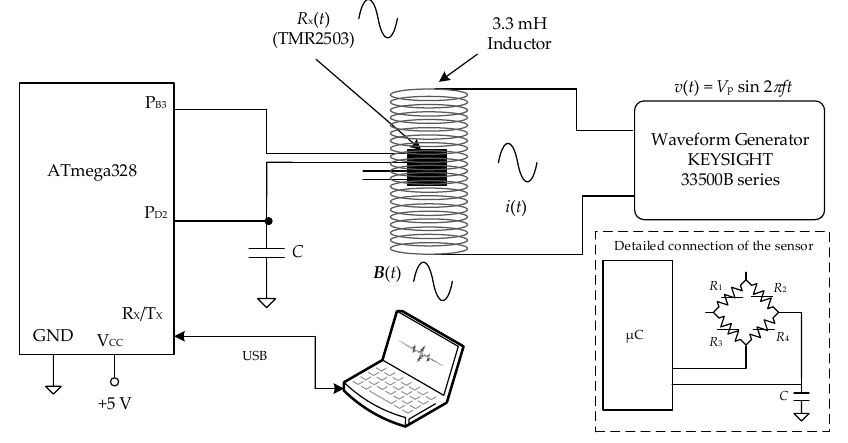
Figure 5. Measurement setup for the dynamic characterization of the DIC.